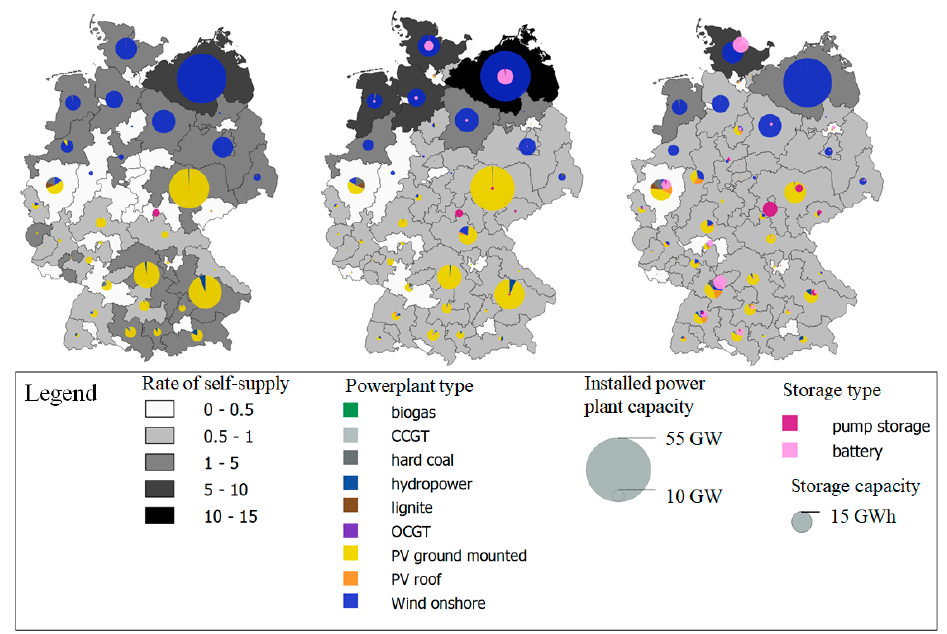
Figure 5. Self-supply share, regional distribution of generation technologies and storage capacities in the year 2050 in the scenario “Stagnation and scepticism—central” for the variant A’ ( left ), A ( middle ) and B ( right ).